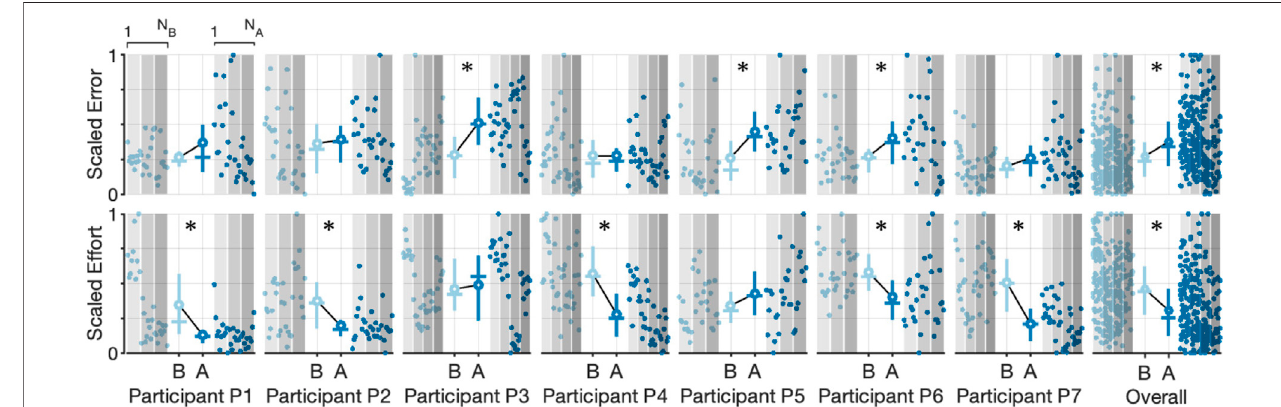
FIGURE 7 | Scatter plots and corresponding interquartile range (Q3-Q1) shown as vertical lines, mean value (solid circle), median value (horizontal line), and the trendlineforscalederrorandscaledeffortforeachcycleduringtheInertia-Dominatecondition.Observationsareplottedinorder(1to N B forthebaselineconditionand1 to N A for the assistance condition). Increasing shaded regions denote each experimental block. Asterisks denote a signi fi cant ( p ≤ 0 . 05) test decision for the null hypothesis that the data from both conditions are from the same distribution using a two-sample Kolmogorov – Smirnov